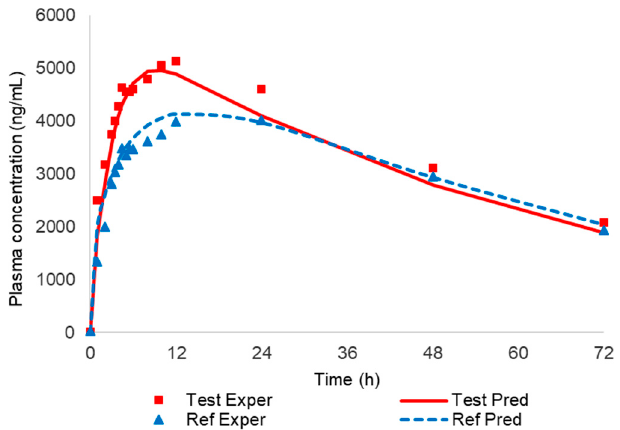
Figure 7. Experimental and predicted plasma levels of both carbamazepine (CBZ) formulations with the two-step IVIVC Level A approach.